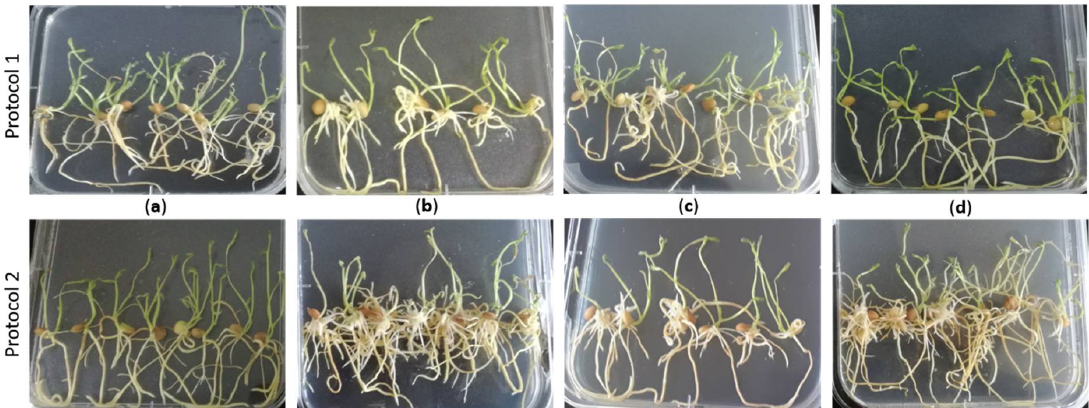
Figure 4. Comparative phenotype of lentil seedlings transformed with different bacterial stains, according to transformation protocols 1 and 2, three weeks after inoculation. ( a ) Non-transformed seedlings; ( b ) seedlings transformed with A. rhizogenes strain R1000 ; ( c ) seedlings transformed with A. rhizogenes strain Κ599 ; ( d ) seedlings transformed with A. rhizogenes strain Arqua.